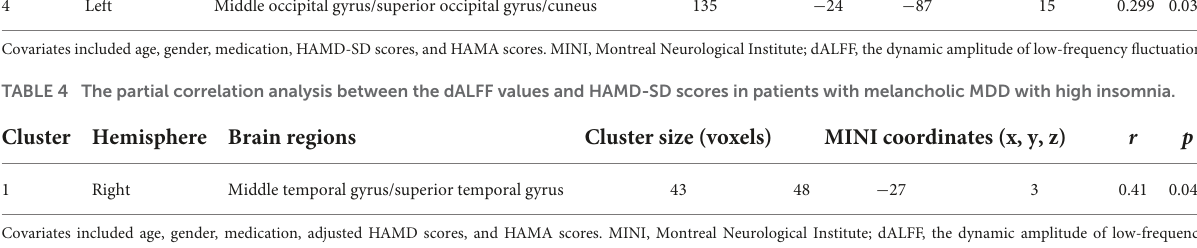
TABLE 3 The partial correlation analysis between the dALFF values and adjusted HAMD scores in the pooled melancholic MDD. Cluster Hemisphere Brain regions Cluster size (voxels) MINI coordinates (x, y, z) r p 2 Bilateral Calcarine/lingual gyri 92 Right Middle occipital gyrus/superior occipital gyrus/cuneus